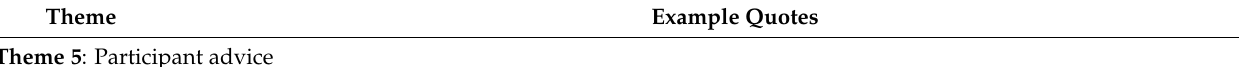
Table 5. Themes providing advice by participants to